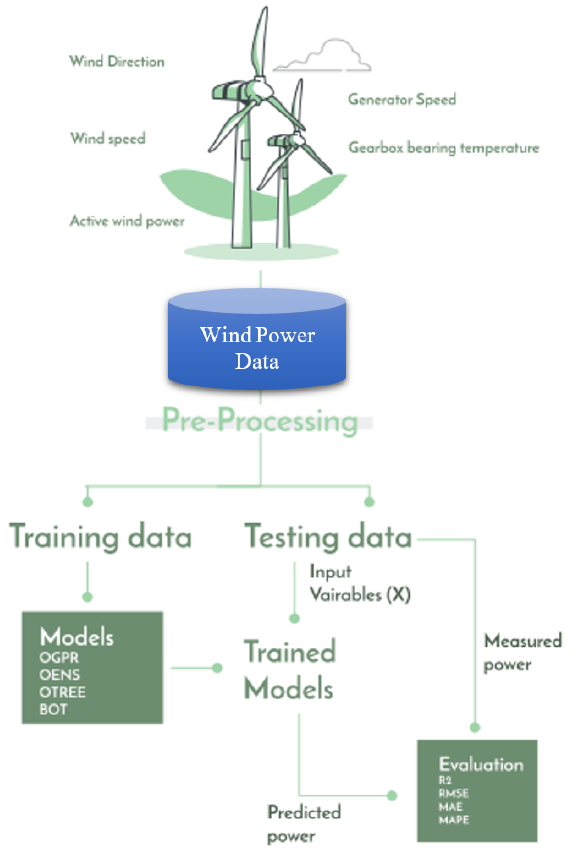
Figure 2. Machine learning-based wind power forecasting